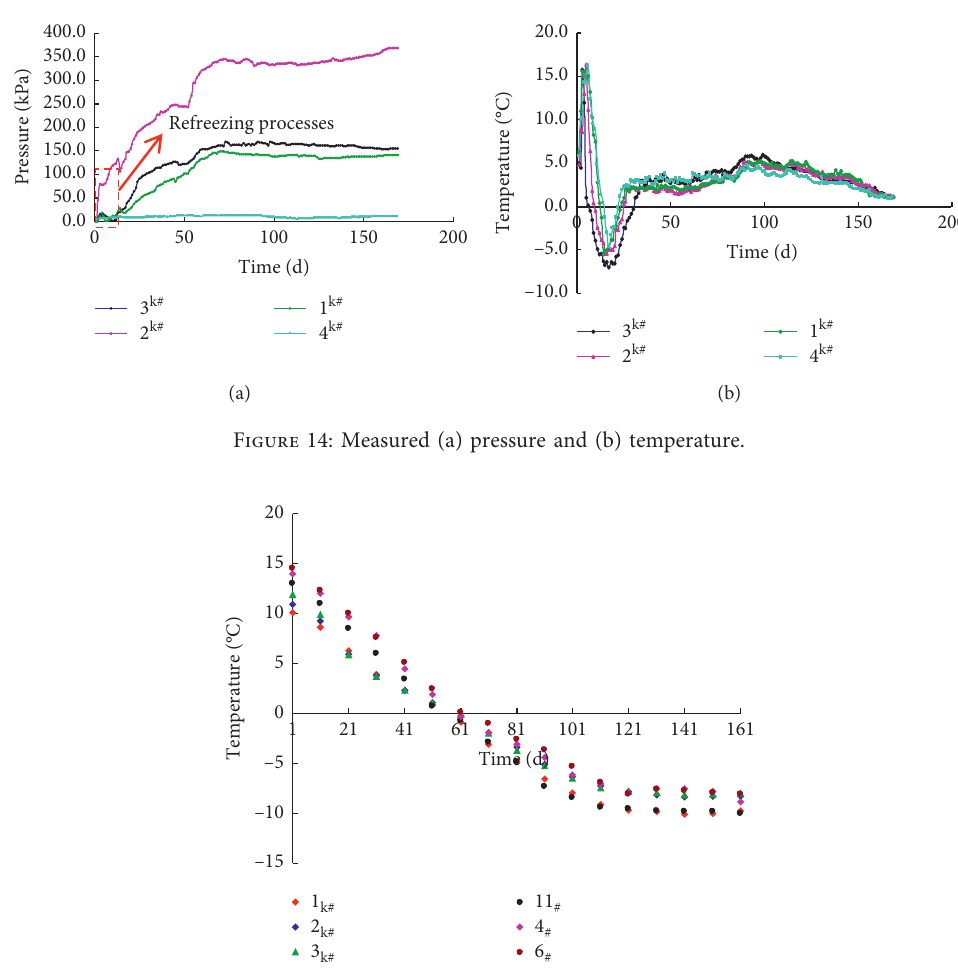
Figure 15: Comparison curve of test and measured